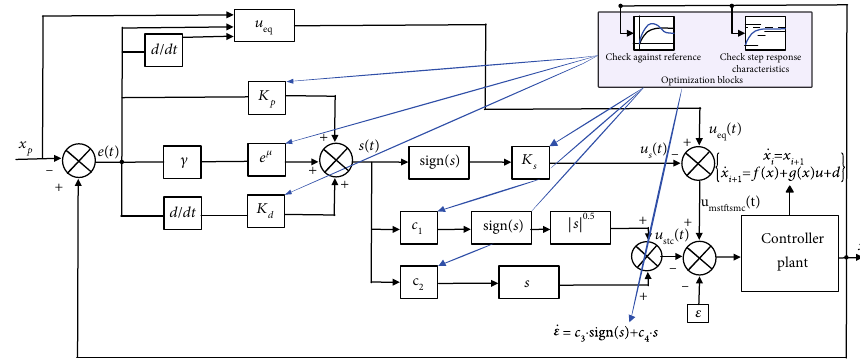
Figure 3: Block diagram of the proposed in this